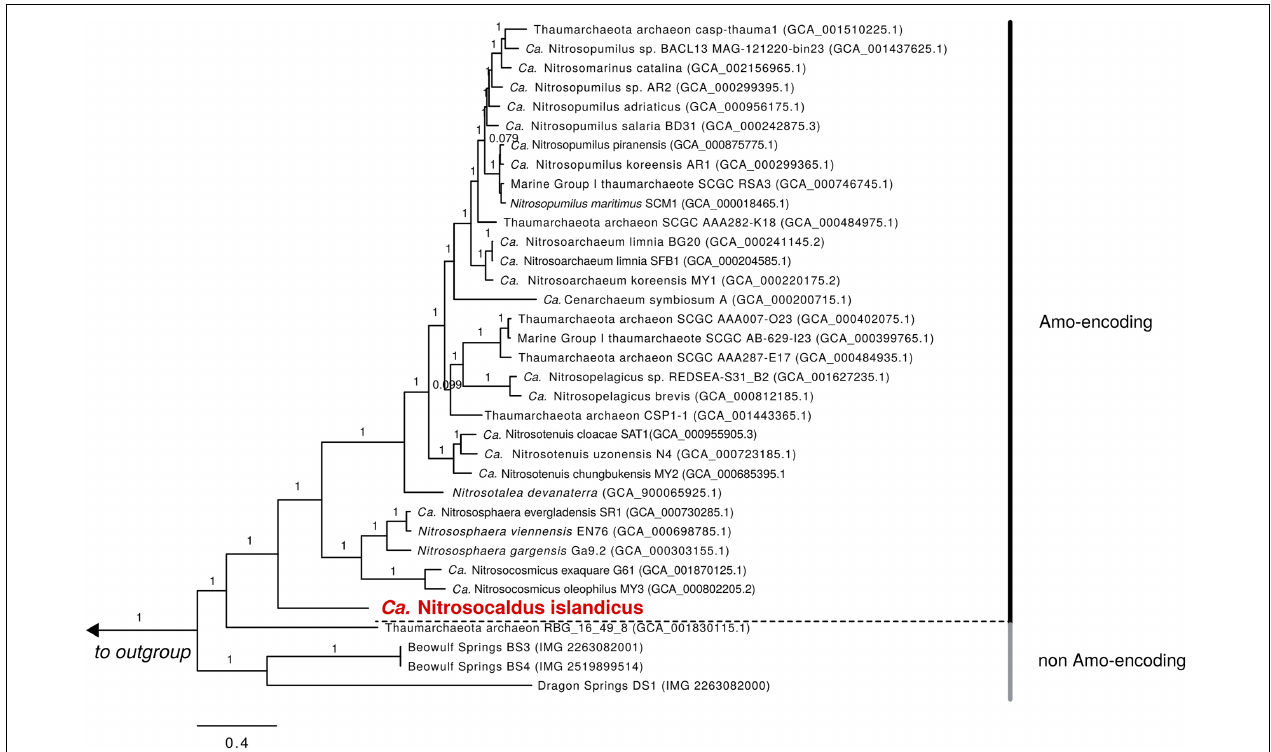
FIGURE 3 | Bayesian inference tree of 34 concatenated universal marker proteins from 31 amoA -encoding Thaumarchaeota including the Nitrosocaldus -like AOA and 4 non- amoA -encoding Thaumarchaeota-like Archaea. Nineteen additional TACK-superphylum (Guy and Ettema, 2011) members (not shown) were used as an outgroup: Aigarchaea (assemblies GCA_000494145.1, GCA_000270325.1), Bathyarchaea (GCA_001399805.1, GCA_001399795.1, GCA_001593865.1, GCA_001593855.1, GCA_001593935.1, GCA_002011035.1, GCA_001273385.1), Crenarchaea (GCA_000011205.1, GCA_000591035.1, GCA_000253055.1, GCA_000813245.1), Geothermarchaea (GCA_002011075.1), Korarchaea (GCA_000019605.1), Thorarchaea (GCA_001563335.1, GCA_001563325.1), and Verstraetearchaea (GCA_001717035.1, GCA_001717015.1). Branches are labeled with average Bayesian posterior probability support over 10 independent chains and the scale bar indicates 0.4 amino acid substitutions per